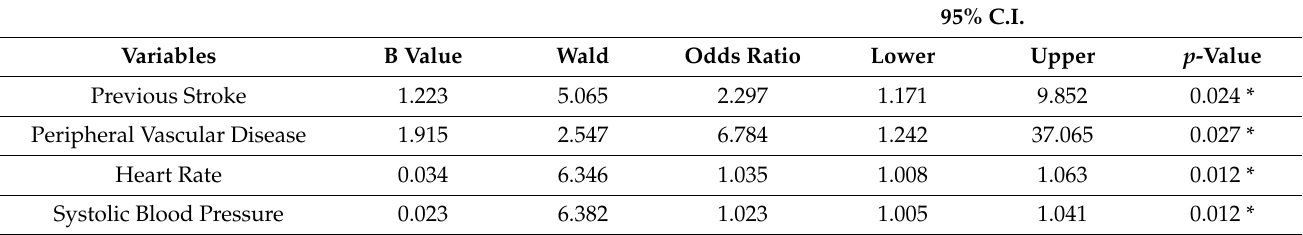
Table 4. Factors associated with stroke severity in the AIS population of Patients with Heart Failure in the age category ≥ 75 years old. Adjusted OR<1 denotes factors that are associated with a lower stroke severity (NIH Score ≤ 7) while OR > 1 denotes factors that are associated with a higher stroke severity (NIH Score > 7). Hosmer-Lemeshow test ( p = 0.348), Cox & Snell (R 2 = 0.141). The overall classified percentage of 70.5 % was applied to check for the fitness of the logistic regression model. * Indicates statistical significance ( p < 0.05) with a 95% confidence interval. 95%